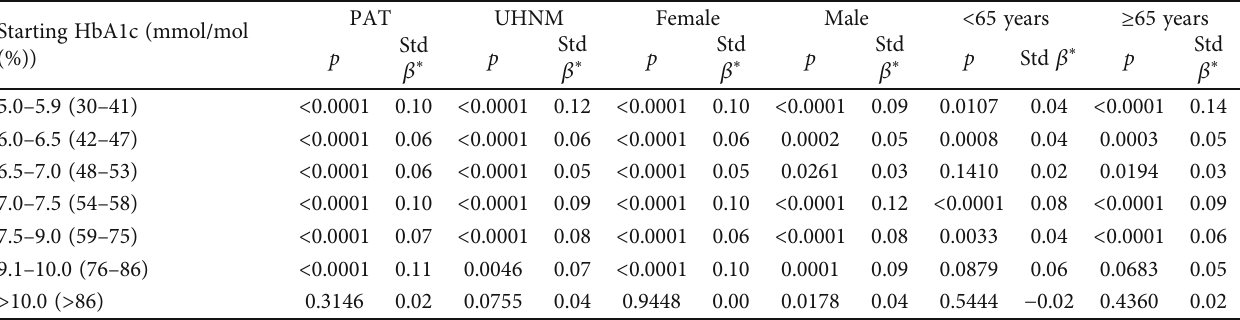
Figure 1: Association between availability in testing interval (expressed as decile of the test interval standard deviation) and change in HbA1c concentration between t and t , strati fi ed by baseline HbA1c: (a) 5.0 – 5.9% (30 – 41 mmol/mol), (b) 6.0 – 6.5% (42 – 47mmol/ 0 0+5yrs mol), (c) 6.5 – 7.0% (48 – 53mmol/mol), (d) 7.0 – 7.5% (54 – 58mmol/mol), (e) 7.5 – 9.0% (59 – 75mmol/mol), (f) 9.1 – 10.0% (76 – 86mmol/ Table 2: Association between variability in HbA1c testing intervals and change in HbA1c, by site, sex, and age. Testing interval de fi ned as standard deviation in testing interval for those with at least 6 tests between baseline and 5 years, corrected for the number of tests and strati fi ed by starting HbA1c; linear